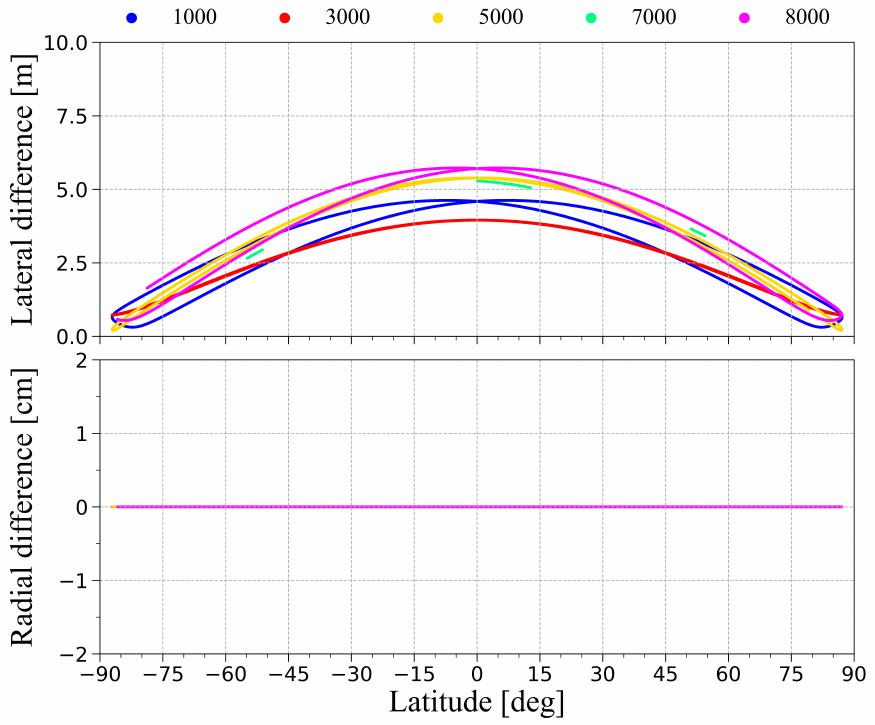
Figure 13. Lateral ( top ) and radial ( bottom ) differences between the footprint locations using the Mars rotational models of Kuchynka et al. [40] and Konopliv et al.